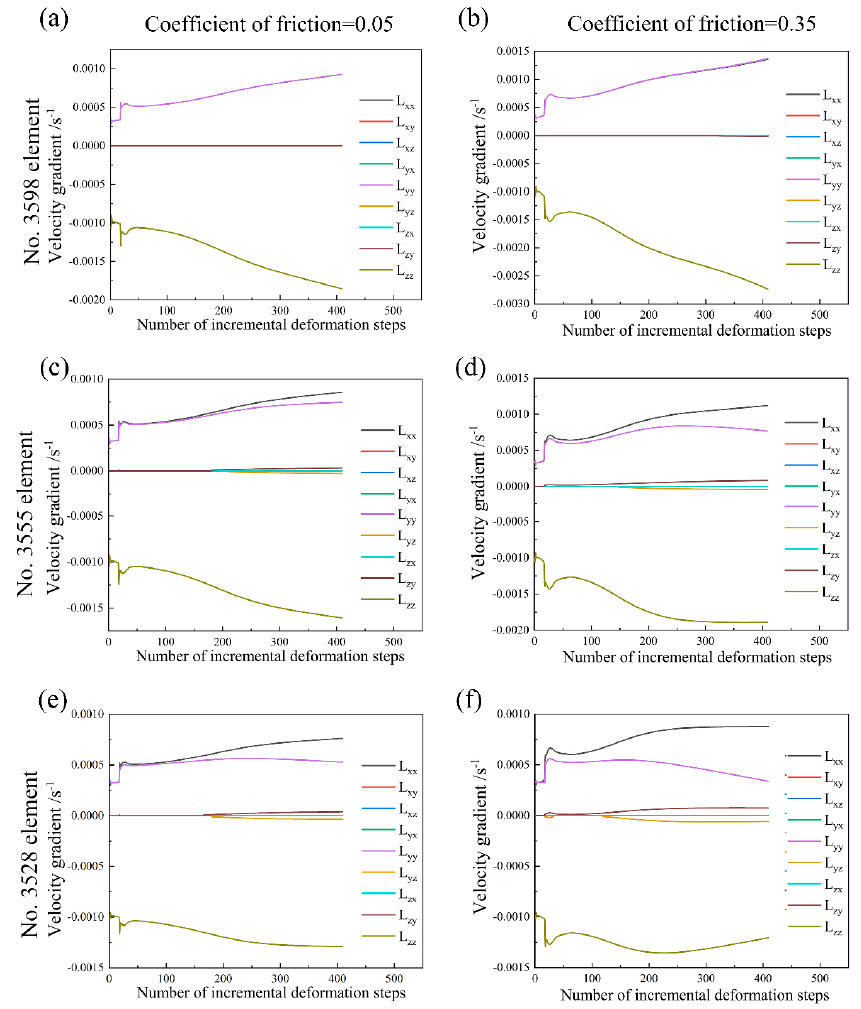
Figure 8. Velocity gradient in No. 3598 element, No. 3555 element and No. 3528 element during uniaxial compression at the deformation degree of 20% with: ( a , c , e ) Friction coefficient of 0.05; ( b , d , f ) Friction coefficient of 0.35.